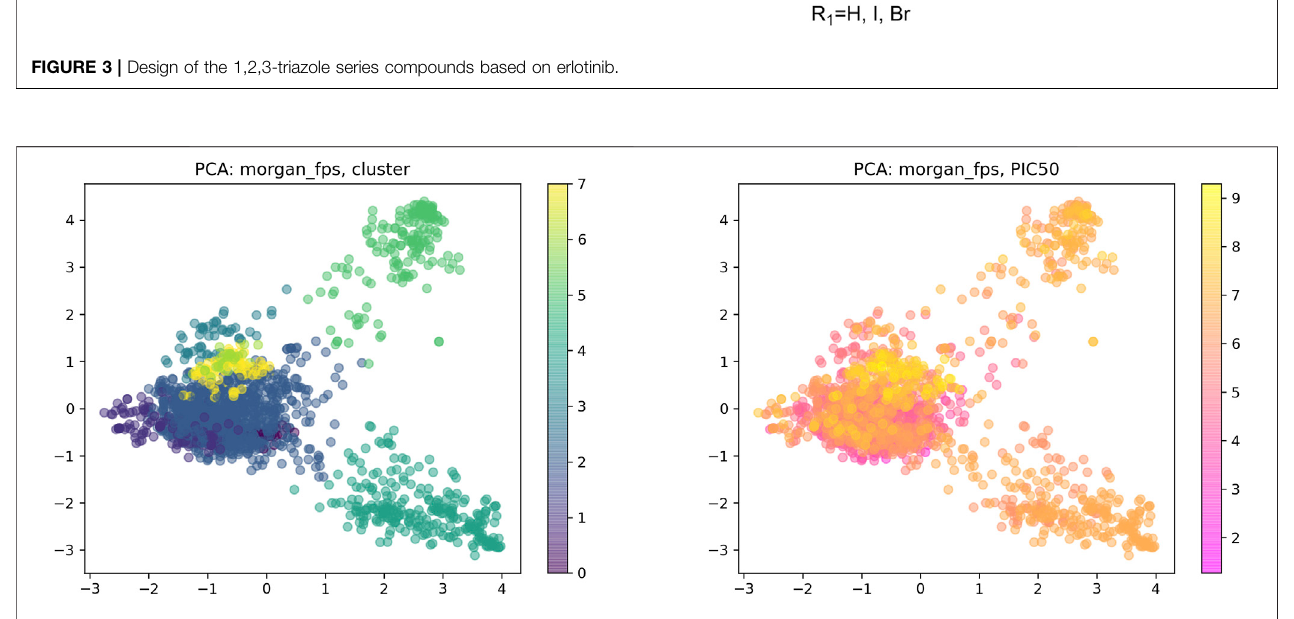
FIGURE 4 | Visual chemical space of the IDO1